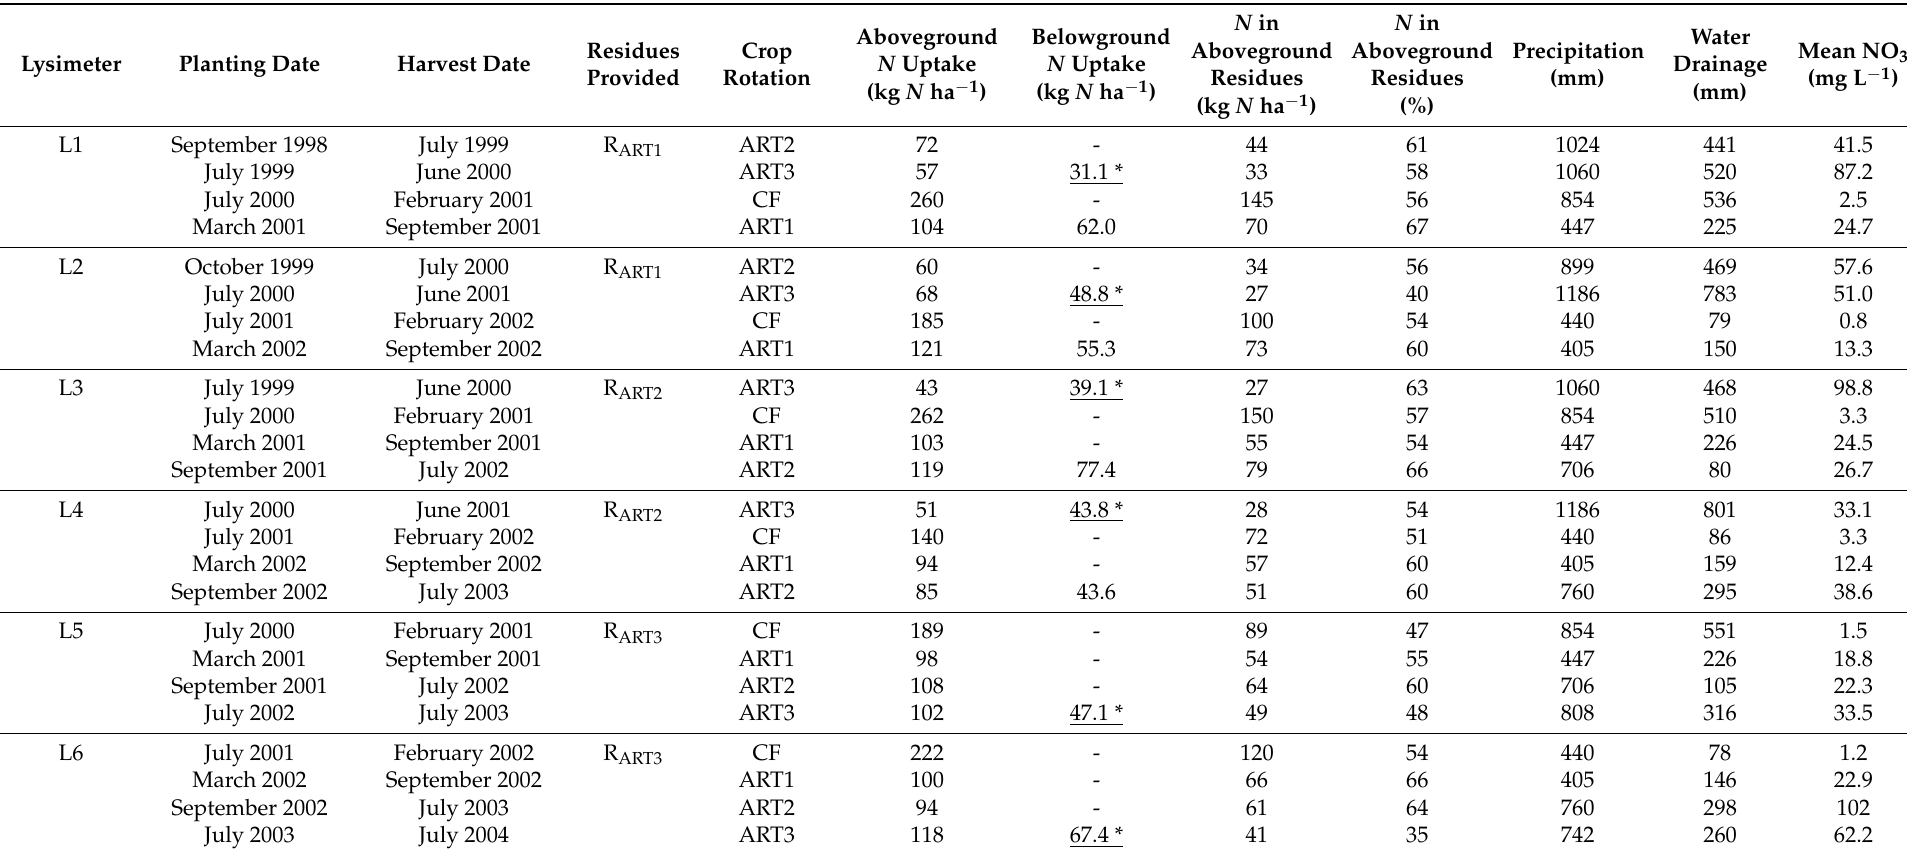
Table 3. Artichoke (belowground, i.e., stump, and aboveground) and cauliflower (aboveground) N uptake by plant biomass. N amounts in crop residues measured in subsequent crops; the percentage of total N uptake returned to the soil; precipitation, water drainage and its mean nitrate (NO 3 ) concentration measured under successive artichoke and cauliflower crops.